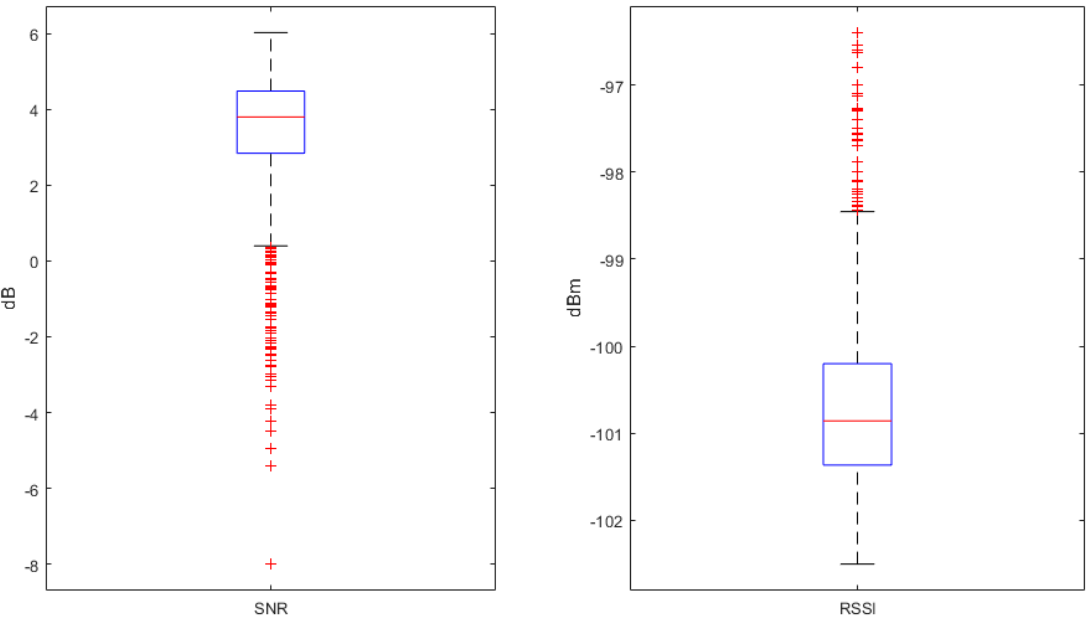
Figure 23. Daily signal statistics—Site B .